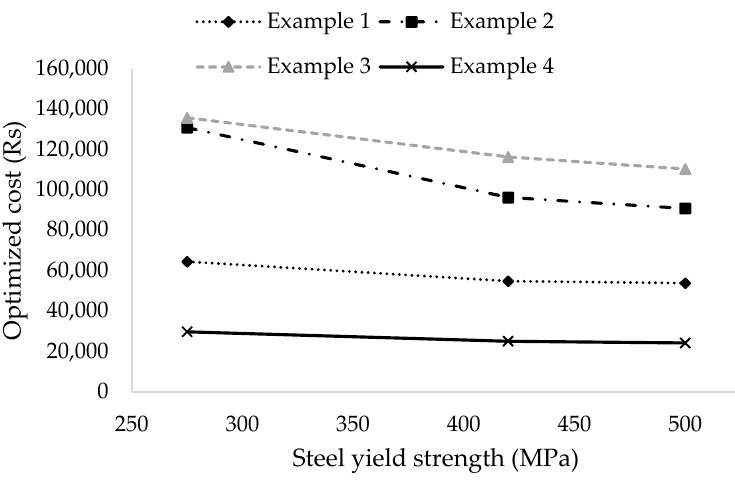
Figure 14. Effect of steel yield strength on cost. Table 11. Variables obtained for example 1 by varying material strength properties.